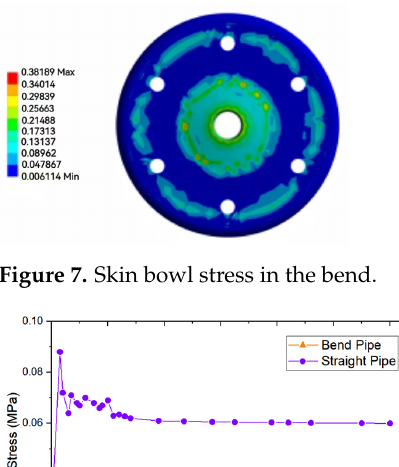
Figure 7. Skin bowl stress in the bend.